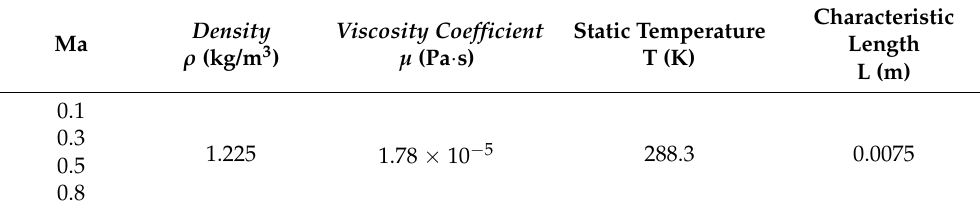
Table 1. Smooth plate calculation conditions.